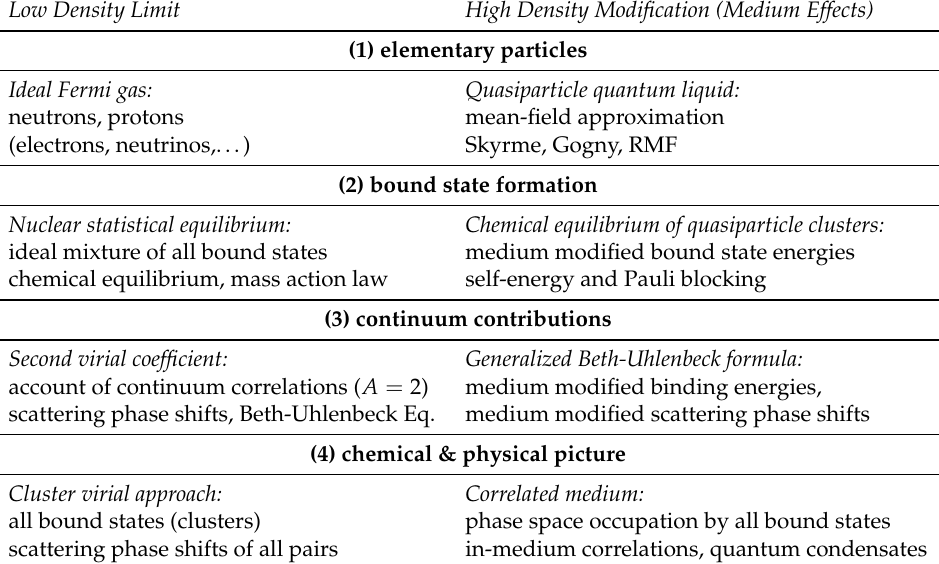
Table 1. Aspects of the quantum statistical description of a many-particle system with bound and scattering states in the low-density limit (left column) and its modification due to medium effects at high densities (right